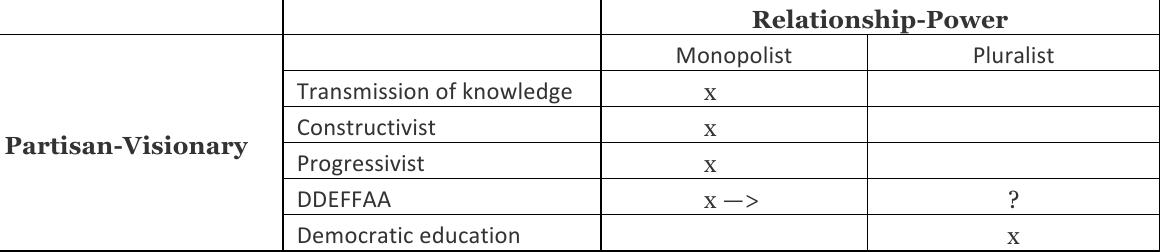
Table 1. Two dimensions of educational